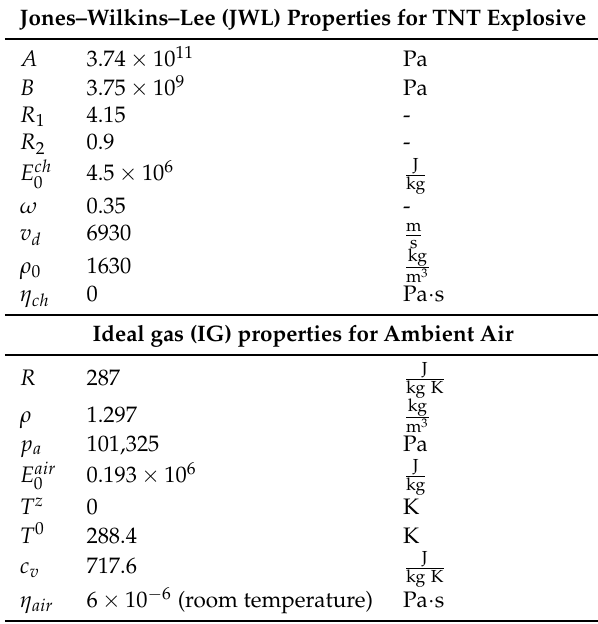
Table 1. Material property for TNT and air [23].